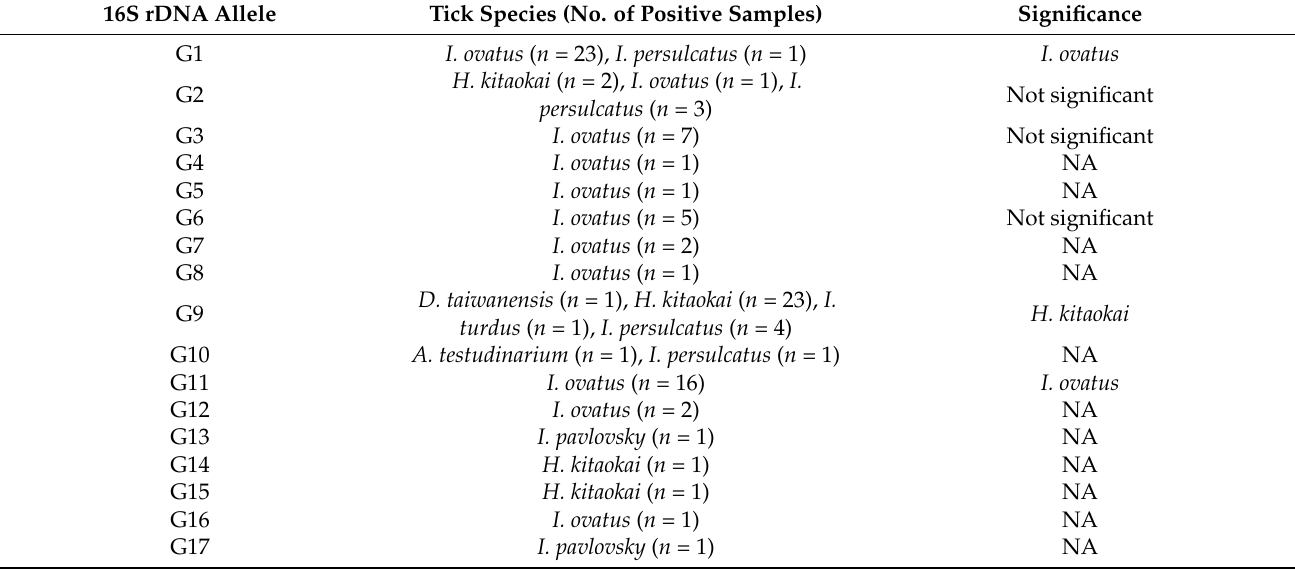
Table 6. Association between Spiroplasma 16S rDNA alleles and tick species. 16S rDNA